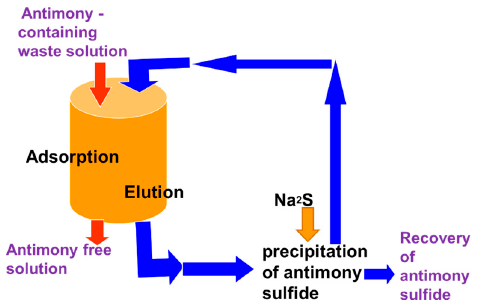
Figure 31. Flowchart showing the recommendation for recovering Sb from waste solutions using SOJR gel.